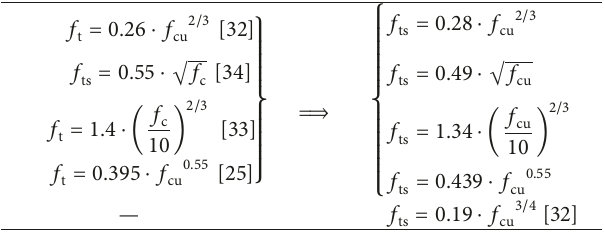
Table 4: The SSE of recommended functions. Proposed functions SSE 3/4 58.0081 𝑓 = 0.19𝑓 ts cu 0.55 25.4530 𝑓 = 0.439𝑓 ts cu 2/3 31.1486 𝑓 = 1.34 ( 𝑓 ts cu /10)